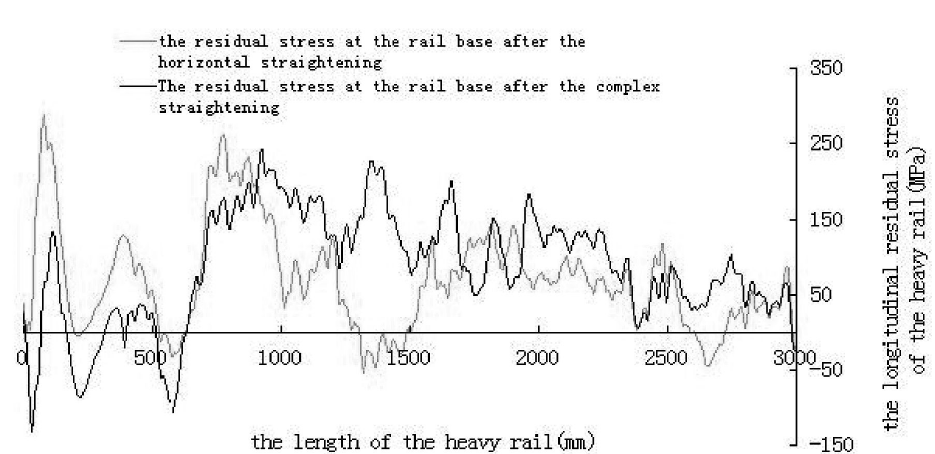
Fig. 10. The mid-nodes residual stress value of rail